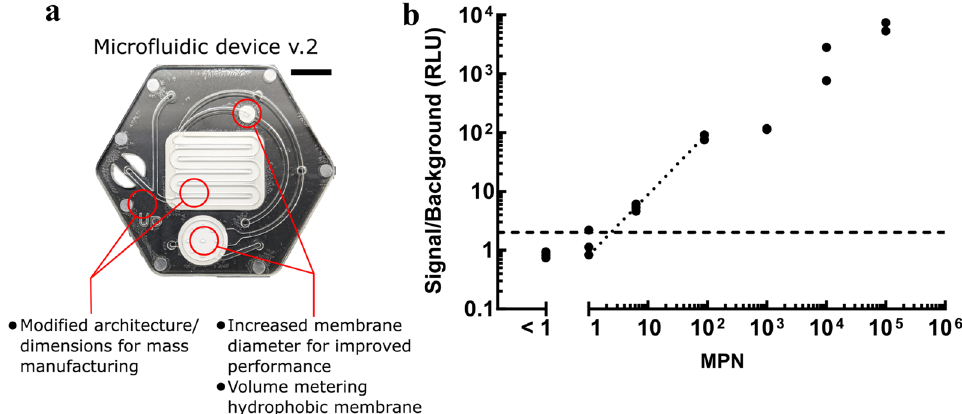
Figure 5. Validation of final phage cocktail assay on local sewage samples. ( a ) Second prototype of the microfluidic device for the detection of E. coli in water samples. Scale bar: 10 mm ( b ) Luminescence signal normalized to phage only background of sewage samples obtained using the 8-phage cocktail and processed through the microfluidic chip device. MPN values were determined with a Quanti-Tray/2000 assay. The